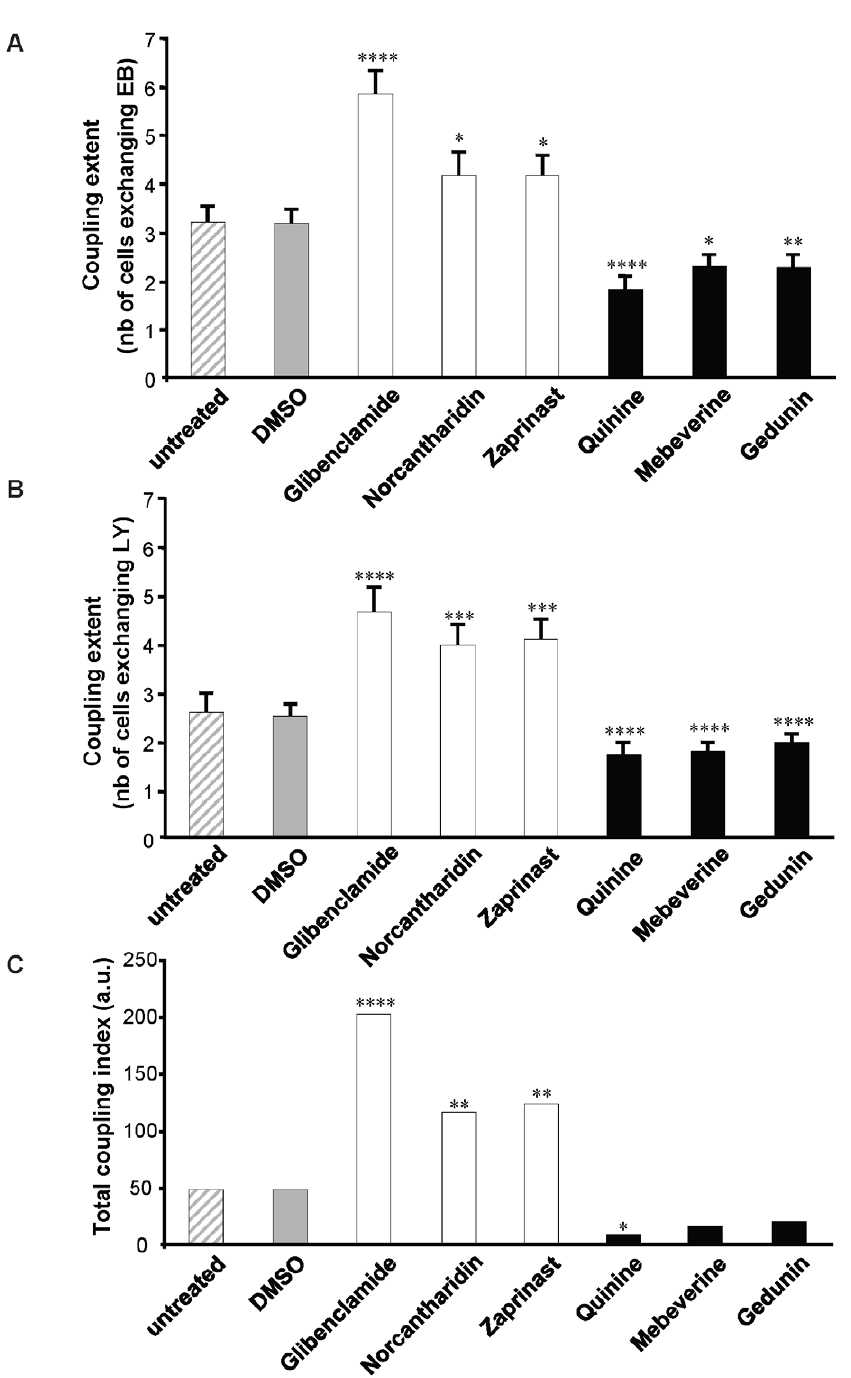
Figure 4. Molecules altering the synchrony index, modify Cx36-dependent coupling. ( A – B ) Microinjection of either EB ( A ) or LY ( B ) revealed a similar extent of coupling in MIN6 cells exposed to DMSO ( gray bars ), the solvent used to dissolve all drugs, and untreated controls ( hatched bars ). All the drugs increasing the synchrony index ( white bars ) increased the extent of coupling, whether the permeability of Cx36 channels was tested with EB ( A ) of LY ( B ). In contrast, all the drugs decreasing the synchrony index ( black bars ) also decreased the extent of coupling tested with either EB ( A ) or LY ( B ). Data are means + SE of the number of injections indicated in Table 1. *p , 0.05, **p , 0.01, ***p , 0.001, ****p , 0.0007 versus values obtained in cells exposed to DMSO; ( C ) Computing of total coupling index, assuming independent permeability of Cx36 channels to EB and LY, showed that coupling was significantly increased by all the drugs enhancing the synchrony index ( white bars ) and reduced by all the drugs decreasing this index ( black bars ). *p , 0.05, **p , 0.01, ****p , 0.0007 versus values obtained in cells exposed to DMSO, using a chi-square test on the number of injections indicated in Table 1.